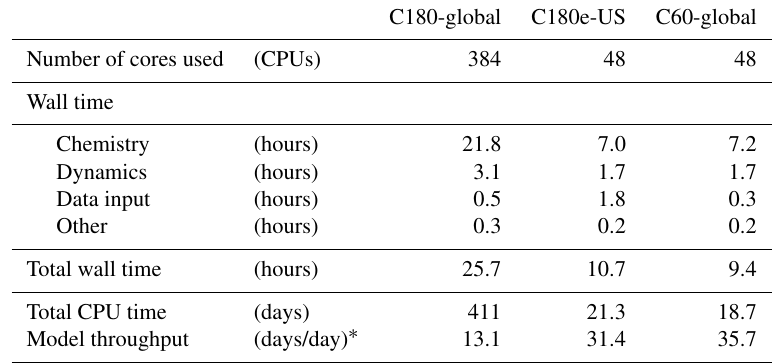
Table 3. The 2-week timing test results comparing the computational expense of C180-global, C180e-US, and C60-global.